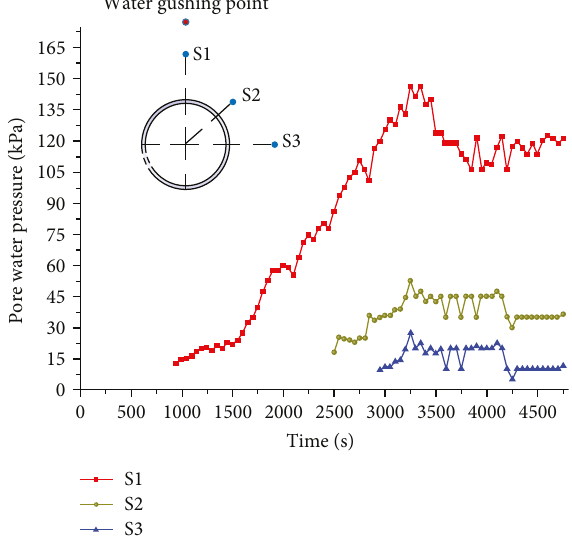
Figure 9: Pore water pressure – time curves of S4, S5, and S6.